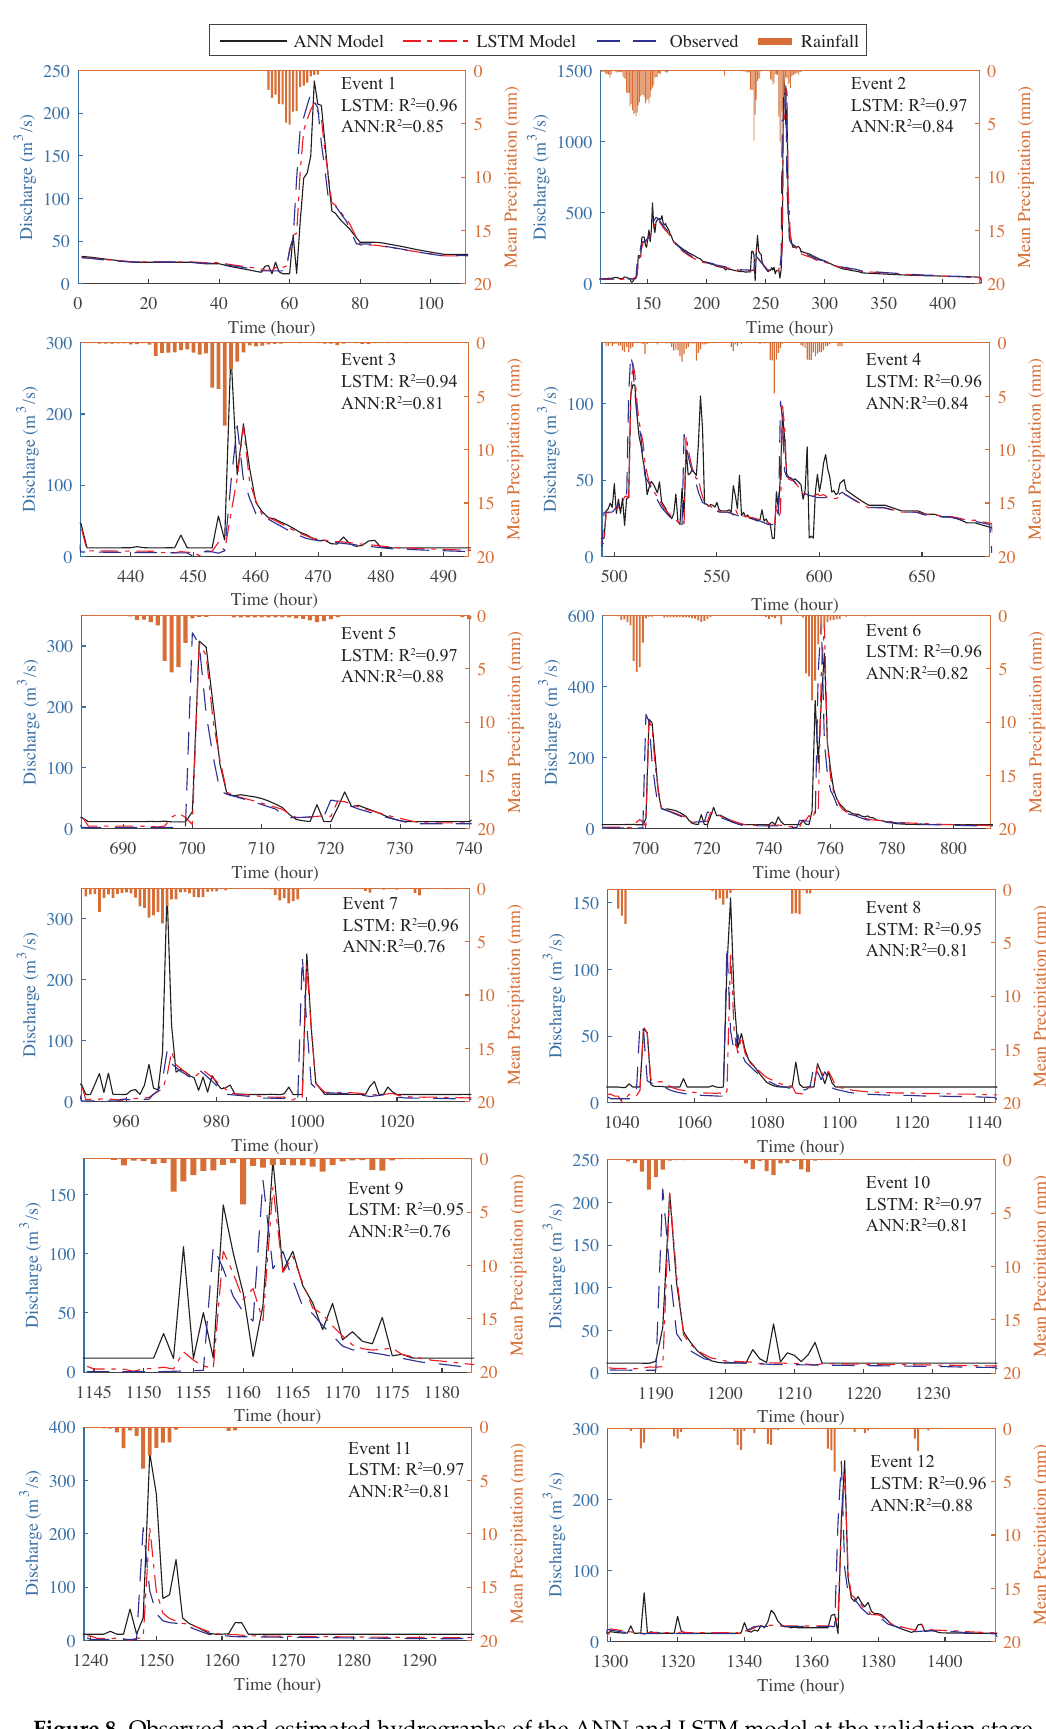
Figure 8. Observed and estimated hydrographs of the ANN and LSTM model at the validation stage in 12 flood